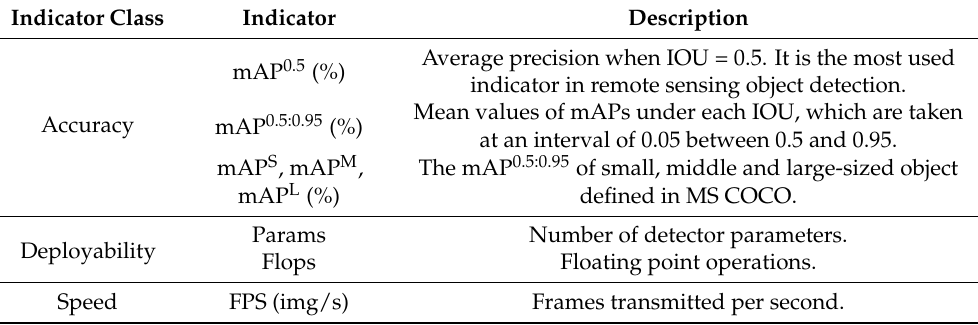
Table 1. The evaluation indicators.